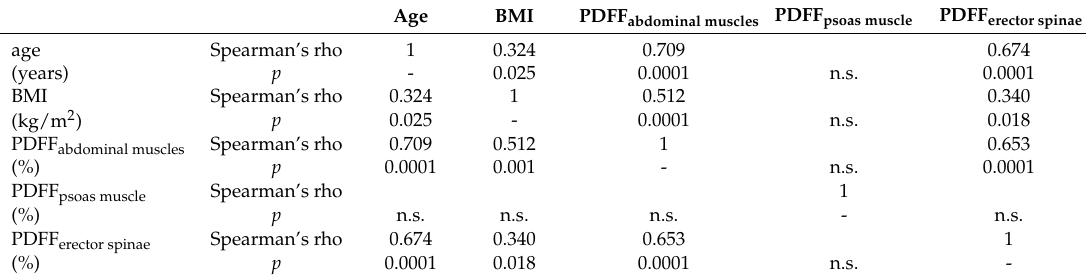
Table 3. In this table Spearman’s rho correlation is depicted for age, BMI, and PDFF in the different muscle compartments in women.